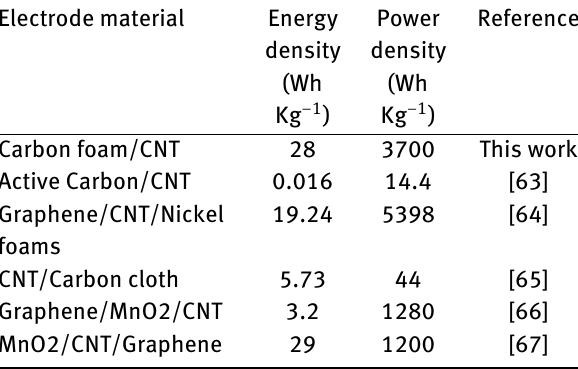
Table 1: Comparison of energy density and power density of differ- ent carbon materials. Values were obtained from the respective